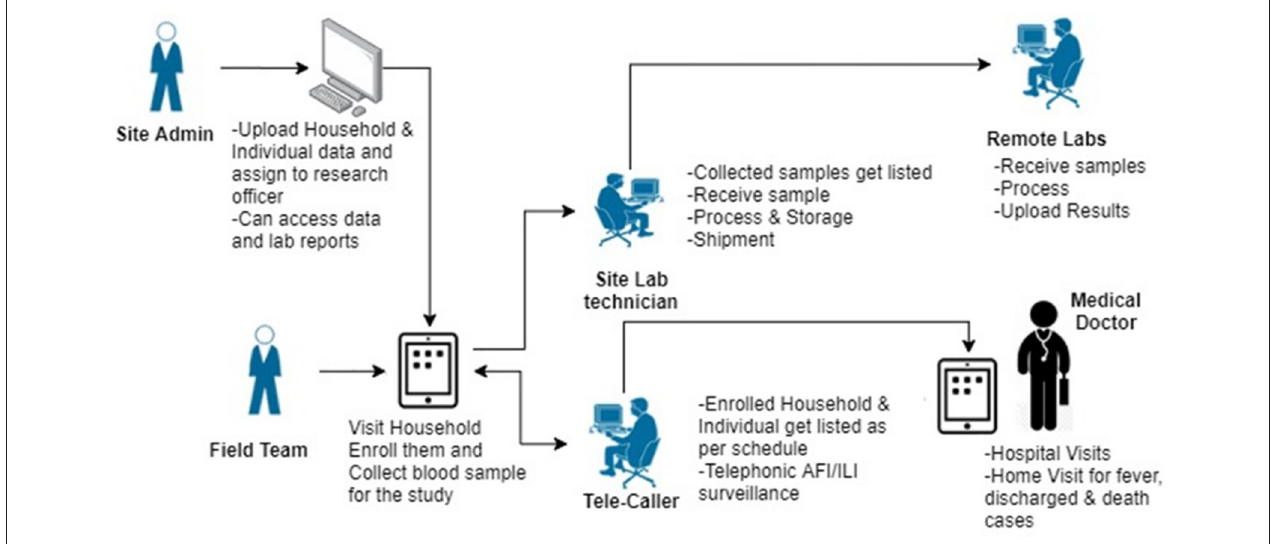
FIGURE 3 | Overview of the SOMAARTH-3 electronic data capture platform.